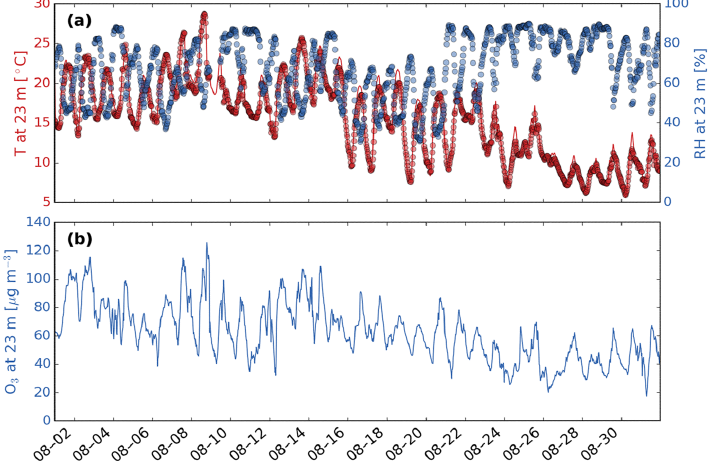
Figure 2. (a) Modelled (solid line) and measured (dots) time series of air temperature ( T , red) and the measured ambient relative humidity (RH, blue) at 23m above the ground. (b) Measured O 3 concentration (blue) at 23m above the ground. The time period is August 2010.